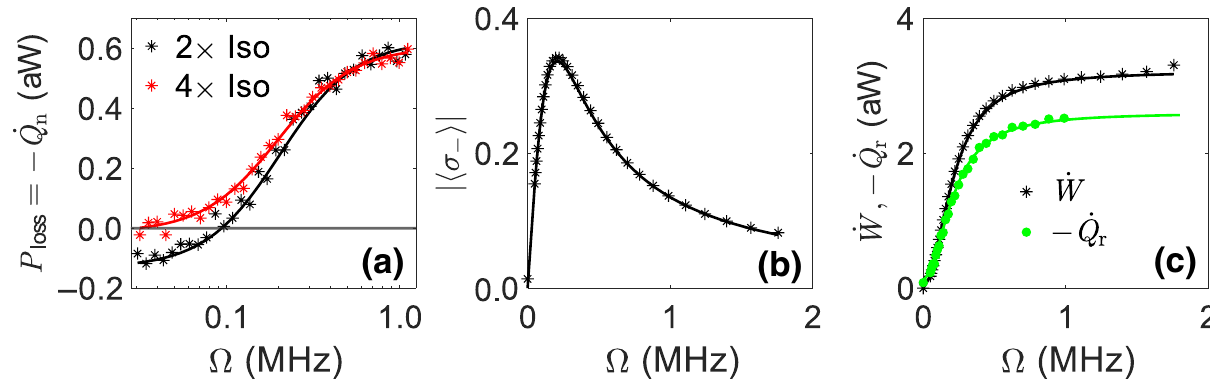
FIG. 4. Power loss, work, and heat. (a) The lost power P loss as a function of the Rabi frequency ( (cid:5) ) of the drive with two and four isolators. (b) The magnitude of the qubit emission as a function of (cid:5) of the drive with two isolators. (c) Work ( ˙ W ) performed and heat ˙ ( Q ) generated by the drive as a function of (cid:5) . In all panels, the stars are the experimental data and the solid curves are from theory, where the green dots in (c) are from the difference between the values of the black stars in (c) and (a) according to